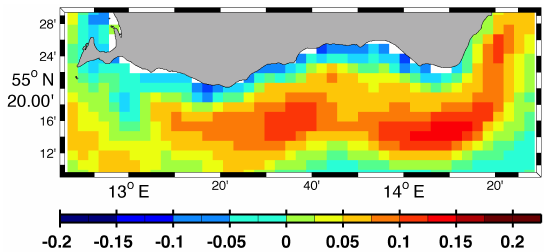
Figure 8. Ekman pumping effected by current–wind interaction (calculated as the difference between experiment REF – noCW; climatological July based on simulated years 1989–1993) in units mday − 1 . Positive values denote additional